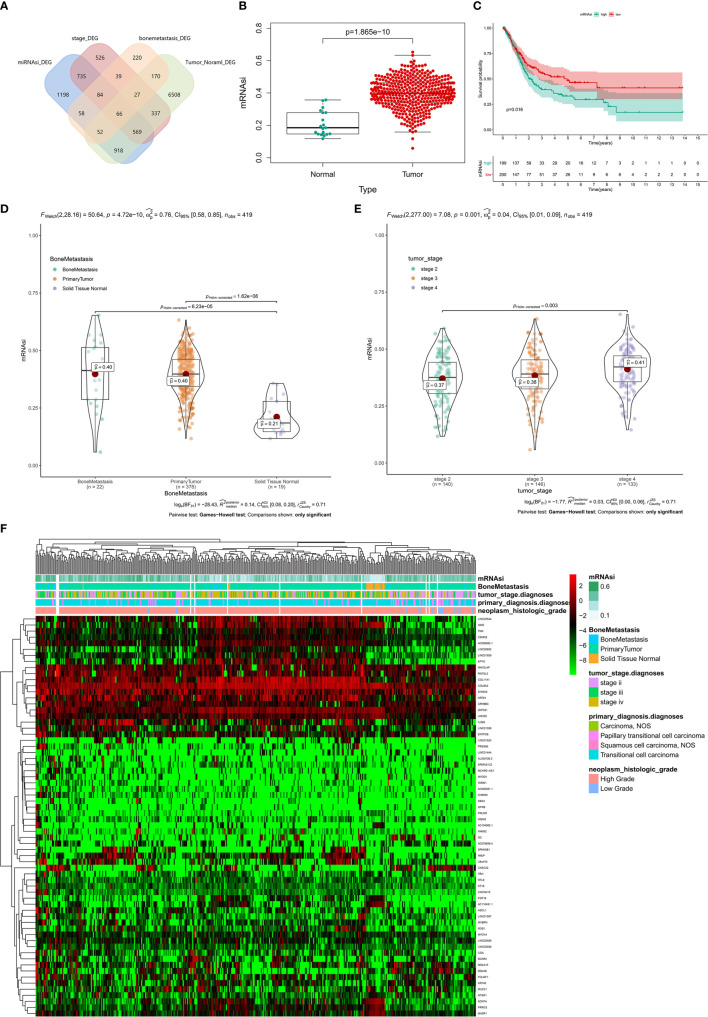
The clinical relevance of mRNAsi and identification of stemness-related genes. (A) The Venn plot of the tumorigenesis-, stemness-, stage- and bone metastasis-related differential expressed genes. (B) The difference of mRNAi between normal and tumor group. (C) Kaplan-Meier survival analysis of mRNAsi between normal and tumor group. (D) The difference of mRNAi among normal, tumor and bone metastasis. (E) The difference of mRNAi among different clinical stage. (F) The heatmap of mRNAsi, bone metastasis, tumor stage, primary diagnosis and neoplasm histologic grade.